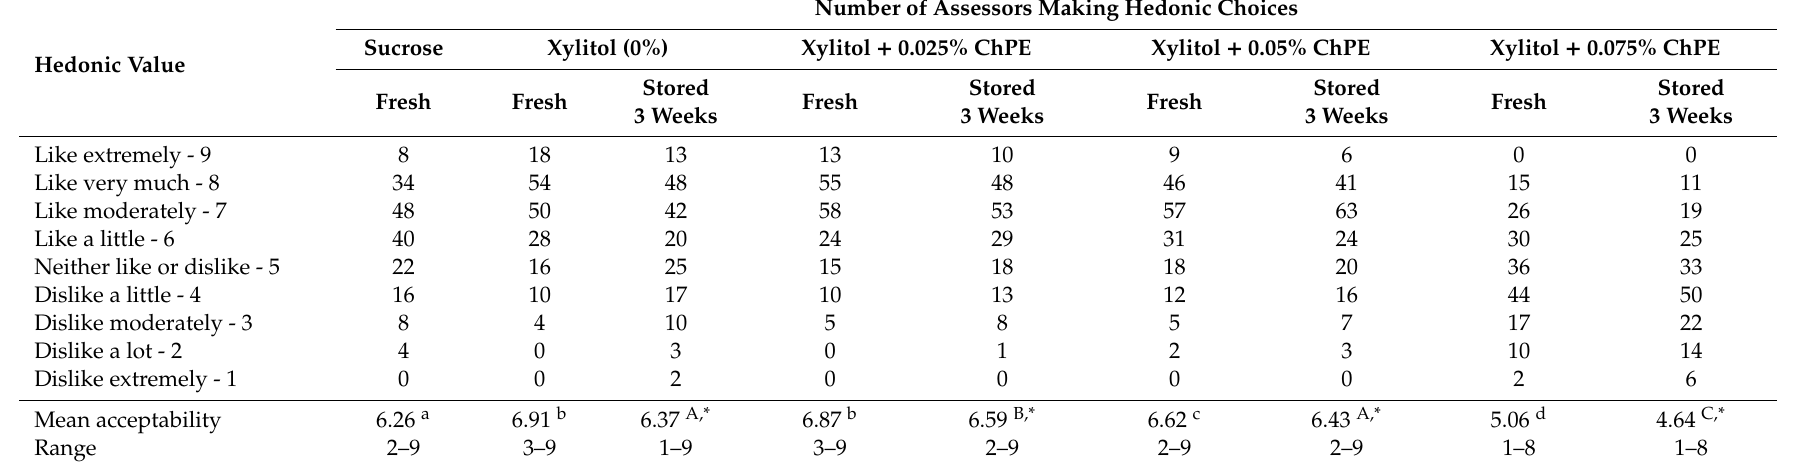
Table 5. Hedonic acceptability of mu ffi ns by assessors (n =